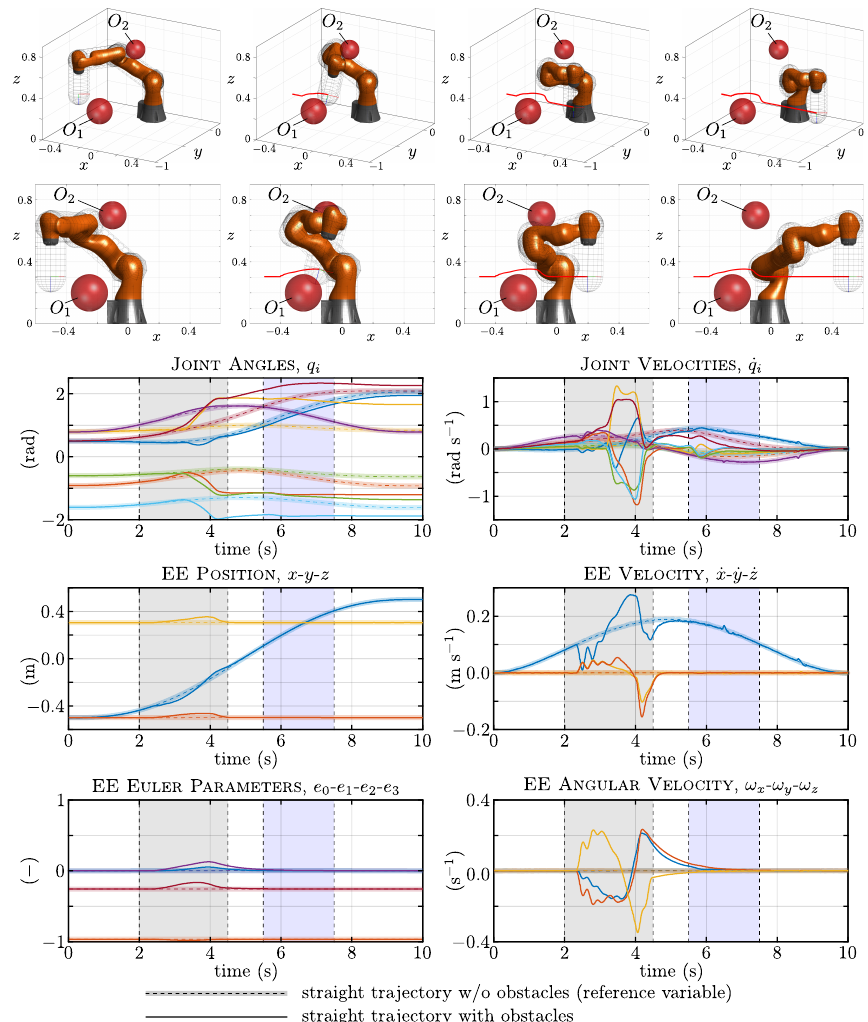
Figure 7. Experimental results: the KUKA iiwa LBR avoiding two different obstacles in its